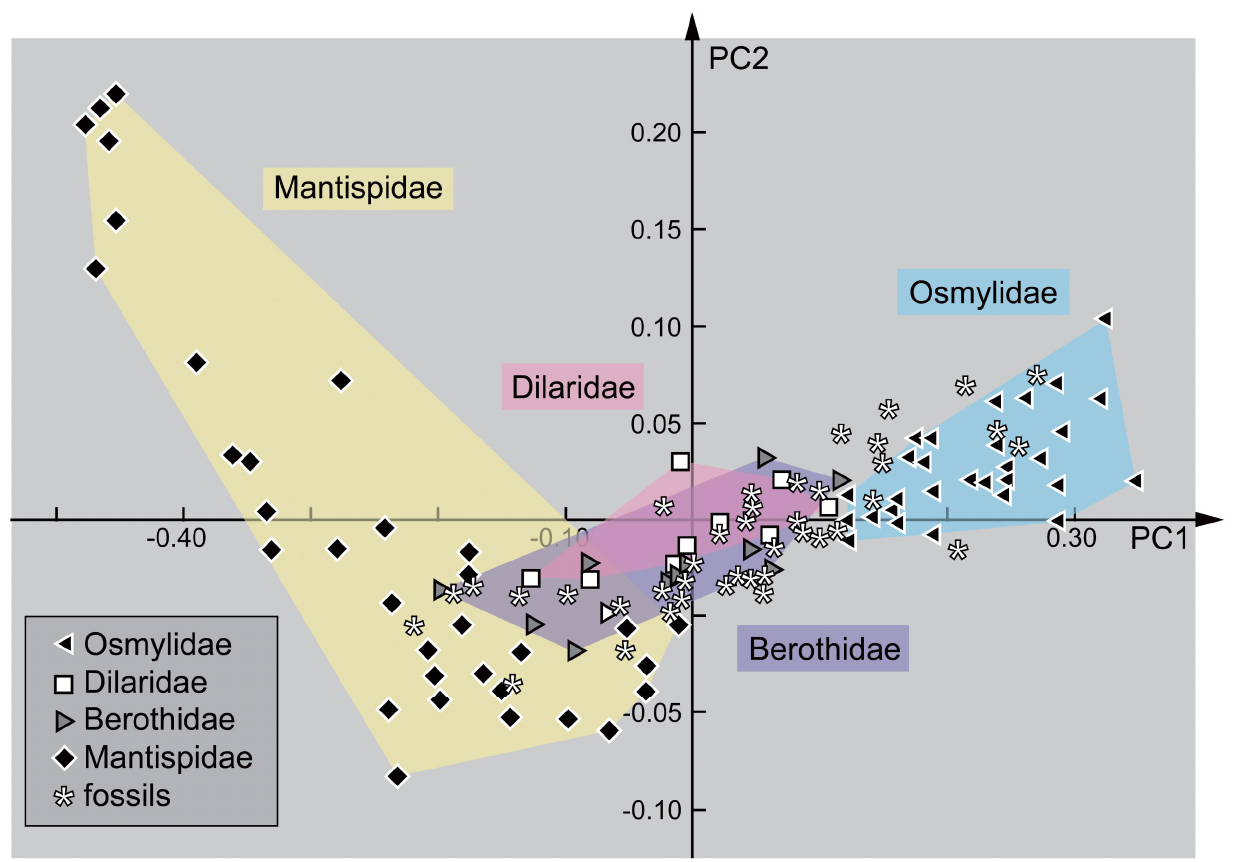
Figure 32. Scatterplot of PC2 vs. PC1 values of head shapes of all